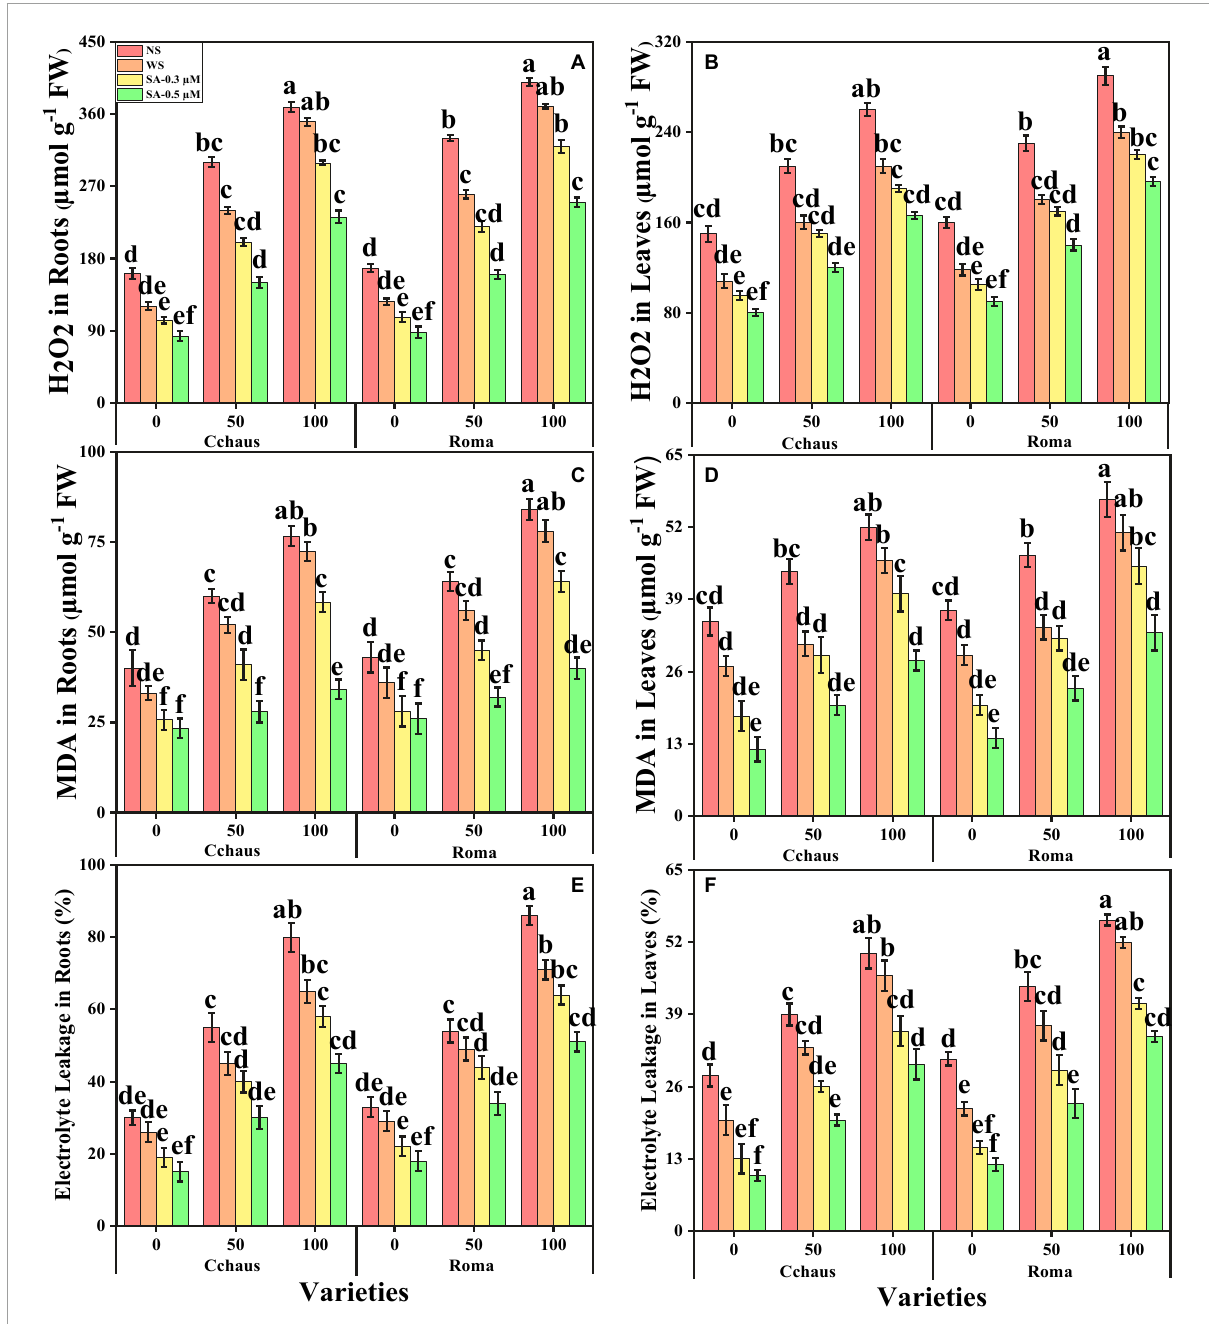
FIGURE3 Effect of exogenously applied syringic acid (0.3-0.5 ◦ µ M) on H 2 O 2 contents in the roots (A) , H 2 O 2 contents in the leaves (B) , malondialdehyde (MDA) contents in the roots (C) , MDA contents in the leaves (D) , electrolyte leakage (EL) percentage in the roots (E) , and EL percentage in the leaves (F) on Solanum lycopersicum varieties (Cchaus and Roma) cultivated under stress levels of Pb [0 (no Pb), 50 and 100 mg kg − 1 ]. Values are demonstrated as means of four replicates along with standard deviation (SD; n = 4). Two-way ANOVA was performed and means differences were tested by HSD ( P < 0.05) through Tukey’s test. Different lowercase letters on the error bars indicate significant difference between the